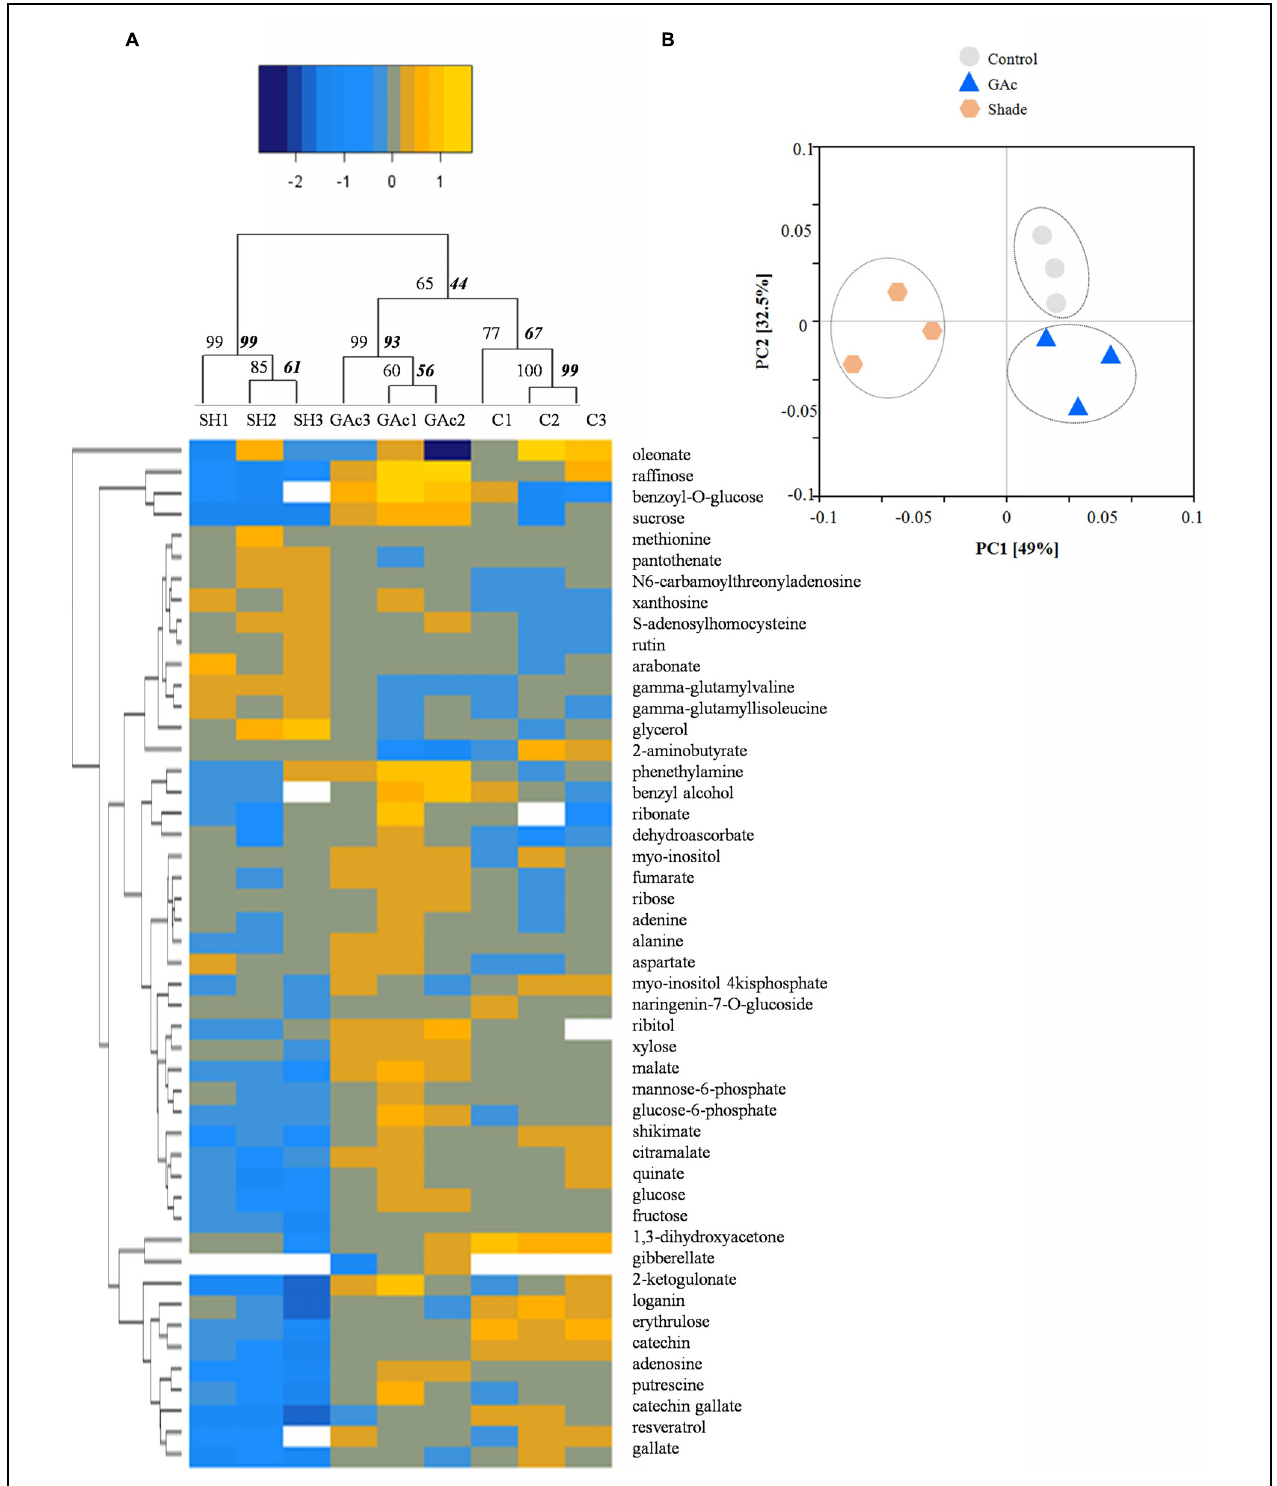
FIGURE 4 | Hierarchical cluster (A) and principal component analysis (B) of the significantly changed metabolites. Yellow and blue tones represent metabolites more and less abundant, respectively. The significance of dendrogram nodes was estimated by bootstrap analyses using 1000 permutations. Values represented in the left side of internal nodes are the